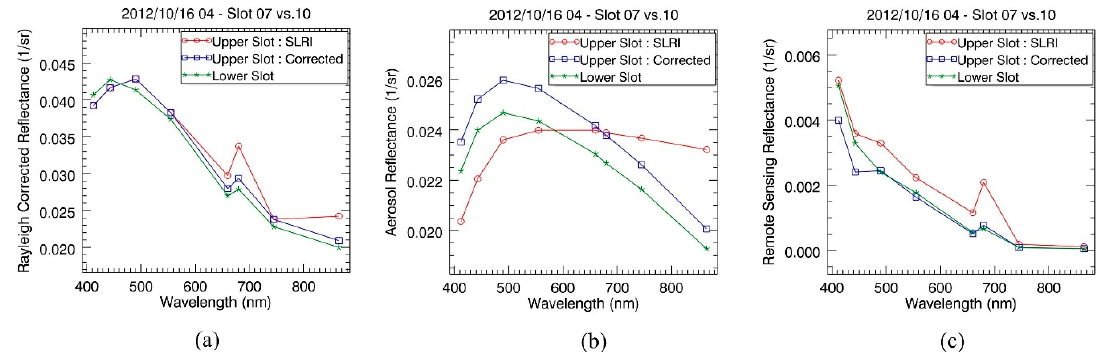
Figure 4. Spectra for ( a ) Rayleigh-corrected reflectance ( ρ rc ); ( b ) aerosol reflectance ( ρ a ); and ( c ) remote sensing reflectance for three types of data source ( R rs ): (red) SLRI-present data, (blue) data corrected by CIDUM, and (green) reference data from the lower slot.